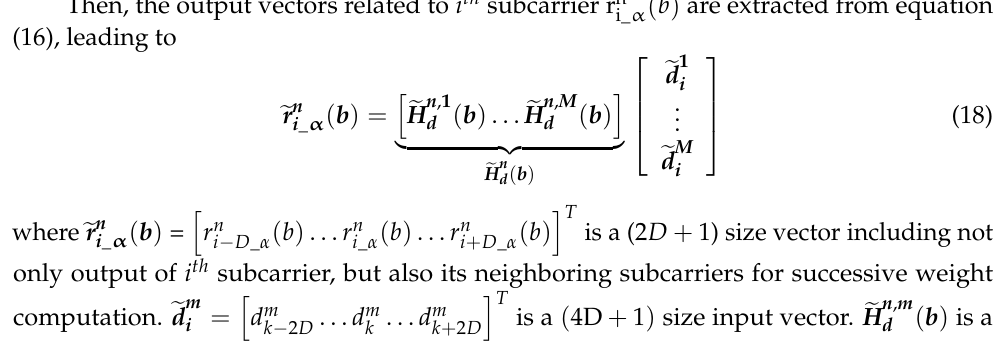
(cid:104) (cid:105) T ( b ) = ( b ) . . . r n ( b ) . . . r n ( b ) r n where (cid:101) r n is a (2 D + 1) size vector including not i _ α i − D _ α i _ α i + D _ α only output of i th subcarrier, but also its neighboring subcarriers for successive tional complexity over a single tap weight combining. In order to solve the problem of matrix inversion in MMSE criterion an 𝐋𝐃𝐋 𝐇 factorization is implemented